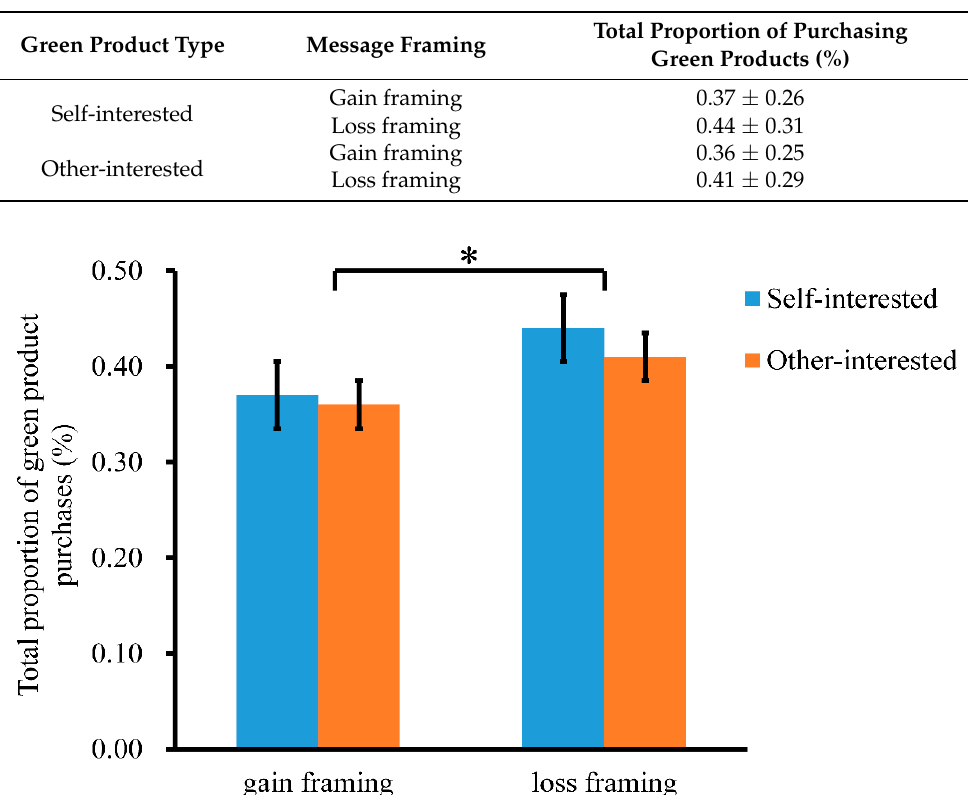
Table 3. Proportion of purchasing green products in purchasing decisions under four conditions ( M ± SD ).